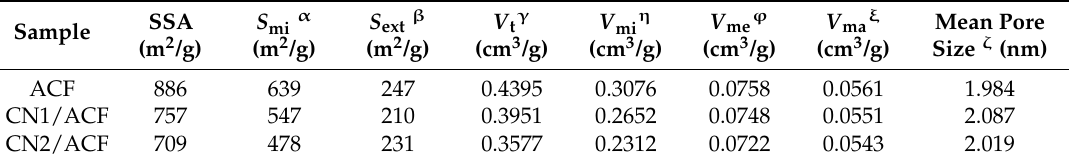
Figure 4. Adsorption isotherms of N 2 at –196 °C on the samples: ( a ) as-received activated carbon fibers (ACF); ( b ) ACF grafted with N-doped carbon nanotubes (CN1/ACF); ( c ) ACF pre-immersed with cobalt(II) acetate and grafted with N-doped carbon nanotubes (CN2/ACF). Table 3. Surface characteristics of the samples determined from N 2 adsorption/desorption isotherms.